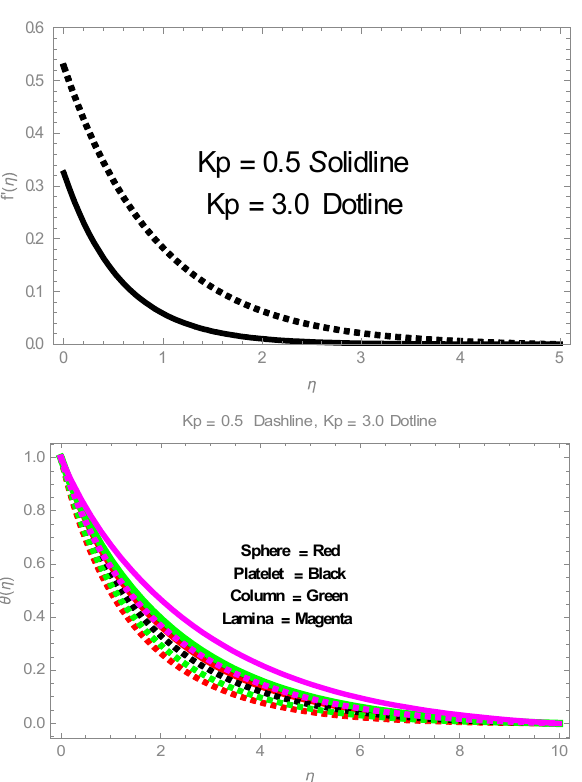
Figure 3. (cid:1858) (cid:4593) (η) and (cid:2016)(η) for dissimilar values of (cid:1839) . Figure 3. f